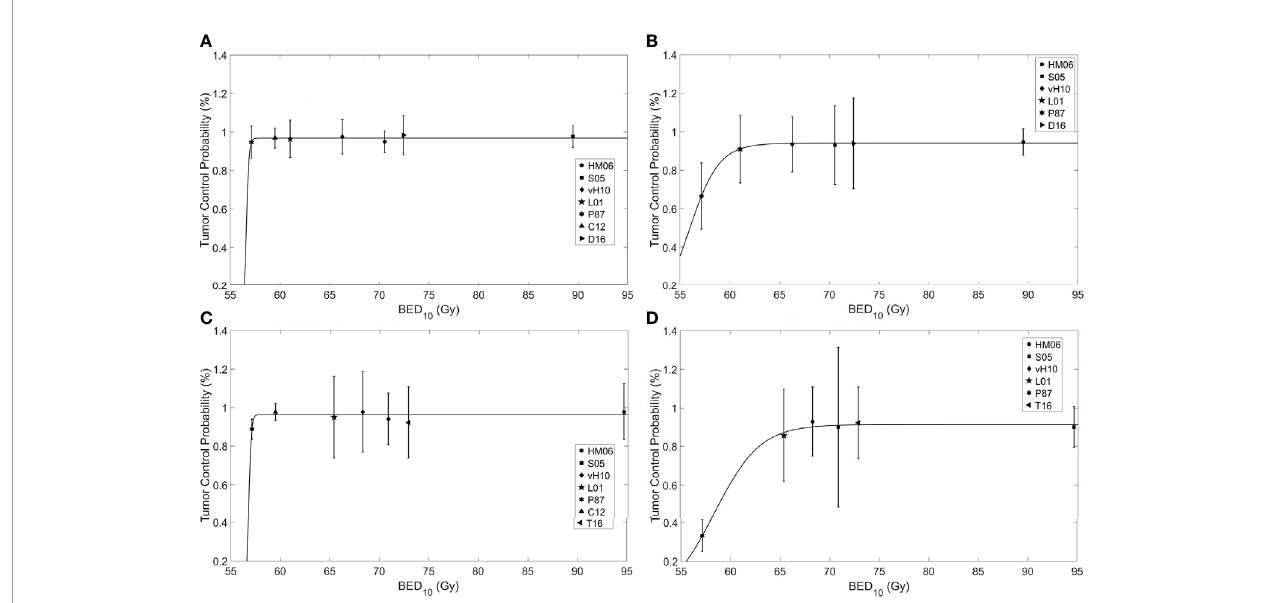
FIGURE 2 | Fitting of a tumor control probability (TCP) model to reported clinical data for basal cell carcinoma (BCC) of size (A) ≤ 2 cm and (B) >2 cm, and cutaneous squamous cell carcinoma (cSCC) of size (C) ≤ 2 and (D) >2 cm. The abscissa is the biological effective dose calculated using the linear quadratic model with a / b = 10 Gy (BED 10 ), while the ordinate is the TCP. HM06, Herna ́ ndez-Machin et al., 2006 (10) (circle); S05, Schulte et al., 2005 (12) (square); VH10, van Hezewijk et al., 2010 (13) (diamond); L01, Locke et al., 2001 (5) (pentagram); P87, Petrovich et al., 1987 (11) (hexagram); Co12, Cognetta et al., 2012 (4) (upward pointing triangle); D16, Duinkerken et al., 2016 (14) (right pointing triangle); T16, Terra et al., 2016 (15) (left pointing